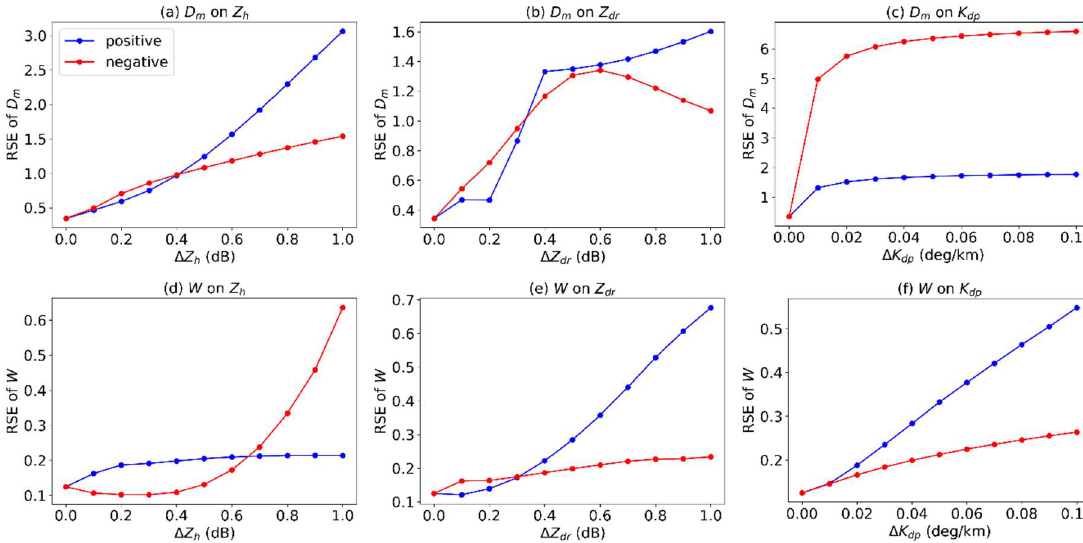
Figure 9. Error characteristics of D m and W associated with the bias of Z h , Z dr , and K dp , respectively, in the disdrometer dataset. The blue curves represent the positive biases, while the red curves are the negative ones.